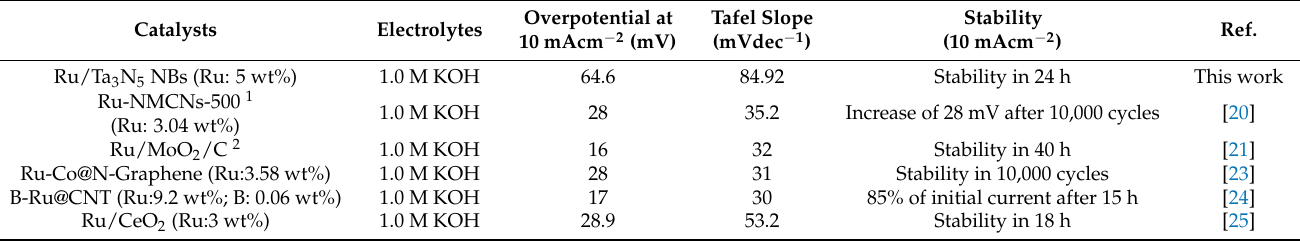
Table 1. HER catalytic activity of Ru-loaded hybrids in alkaline